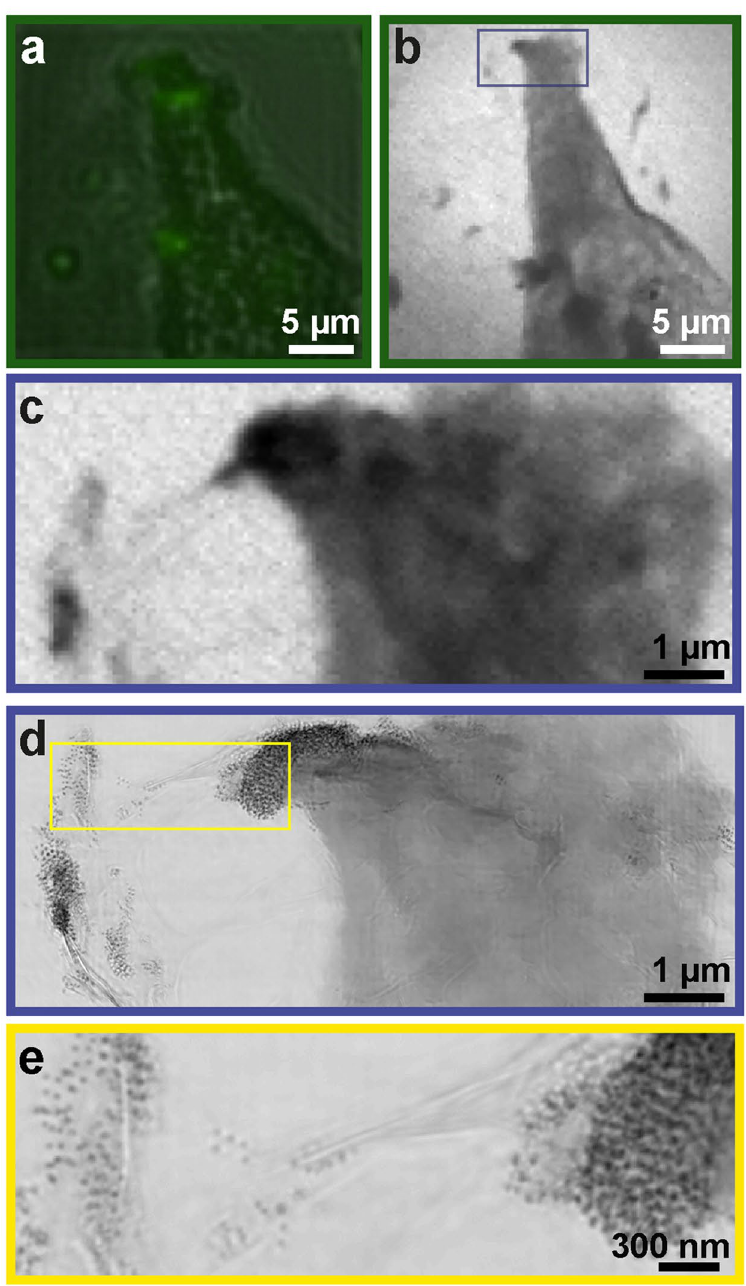
Figure 2. Localization of functionalized nanoparticles in a cellular context with correlative microscopy. ( a ) Part of a HeLa cell containing functionalized nanoparticles was first identified using fluorescent microscopy. ( b ) The same region was imaged using a coarse STXM scan. ( c ) A fine STXM scan was then performed on a smaller region of interest and a tomographic tilt series was acquired from this region. ( d ) Ptychographic imaging was performed on the same region as ( c ) to obtain higher resolution information. ( e ) Individual nanoparticles within and around the leading edge of the cell identified from the ptychographic